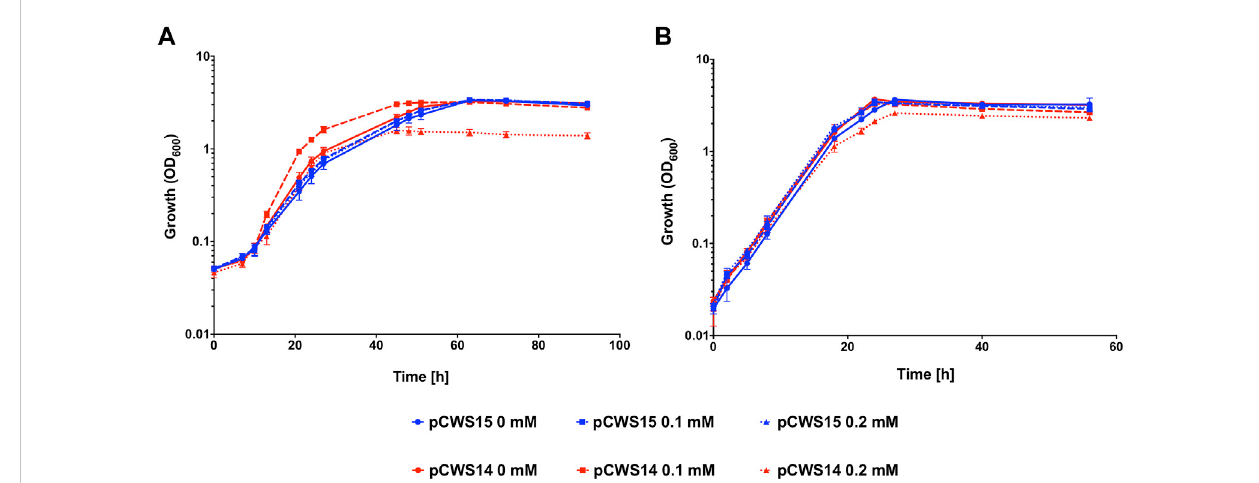
FIGURE 5 Heterotrophicgrowthof C.necator pCWS14and C.necator pCWS15inthepresenceofCO.Culturesweregrownat30 ° Cin20 mLF-MMcontained in 150 mL serum bottles under a 2 bar atm of (A) 50% CO/50% air (v/v) or (B) 50% N 2 /50% air (v/v). Expression of cydA2B2 from pCWS14 using the pBAD promoter was induced with the indicated arabinose concentrations: 0 mM, red line; 0.1 mM, red dashed line; 0.2 mM, red dotted line. pCWS15, which contained the arabinose-inducible pBAD promoter but lacked the rfp gene, was induced with the same arabinose concentrations: 0 mM, blue line; 0.1 mM, blue dashed line; 0.2 mM, blue dotted line. Error bars represent the standard deviation of the mean for three independent replicates.